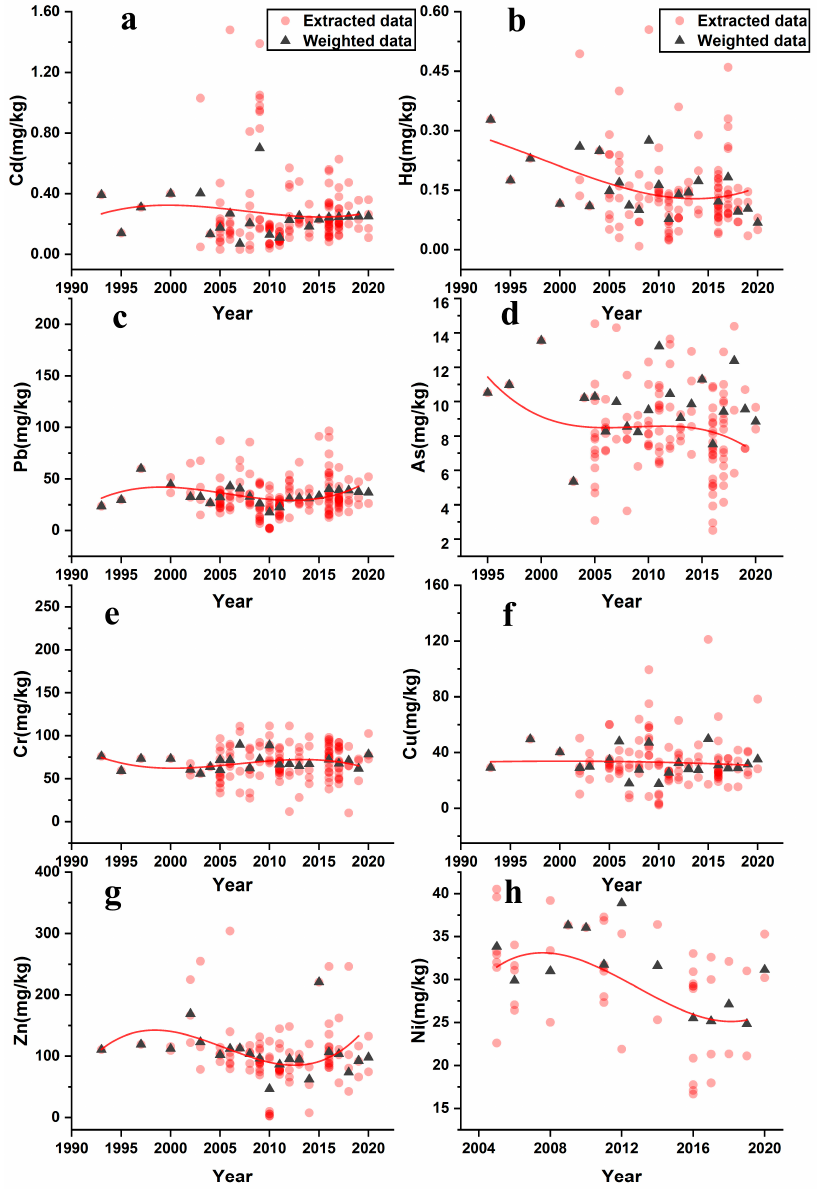
Figure 6. Temporal trend of ( a ) Cd; ( b ) Hg; ( c ) As; ( d ) Pb; ( e ) Cr; ( f ) Cu; ( g ) Zn; and ( h ) Ni contents in agricultural soil in the Yangtze River Delta (YRD); (red points represent all data extracted from articles except outliers; black triangles represent the weighted mean data grouped by years; and red curve is a nonlinear fitting for the extracted data).